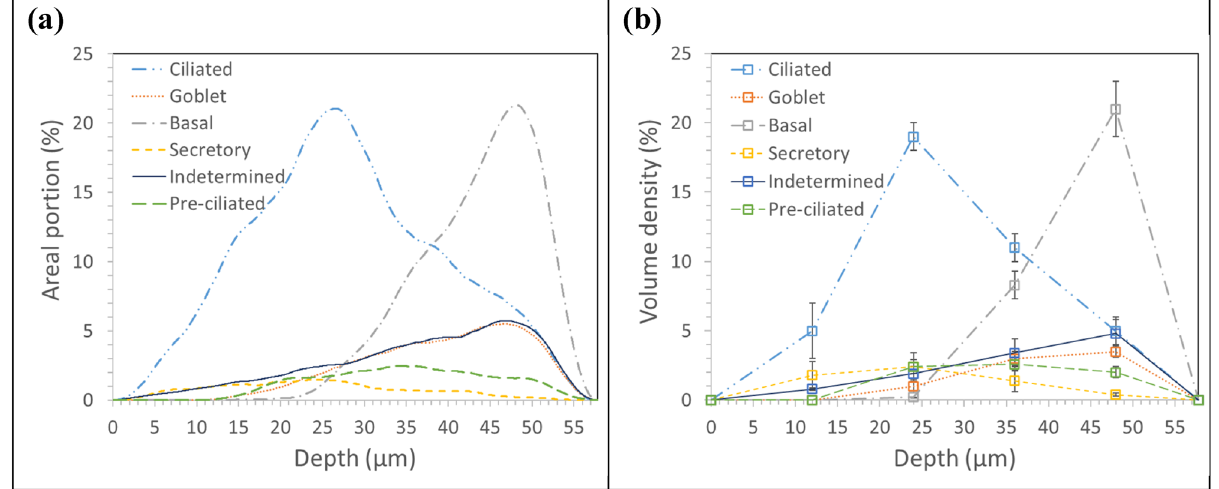
Figure 7. Areal portions of six cell types in the bronchial epithelium as functions of depth from the luminal surface: ( a ) estimates in this study at every 0.02 μm depth of the 57.8 μm-thick tissue segment linked between neighboring data points and ( b ) measurements by Mercer et al. 54 at six discrete depths of the bronchial epithelium linearly interpolated between neighboring data points.